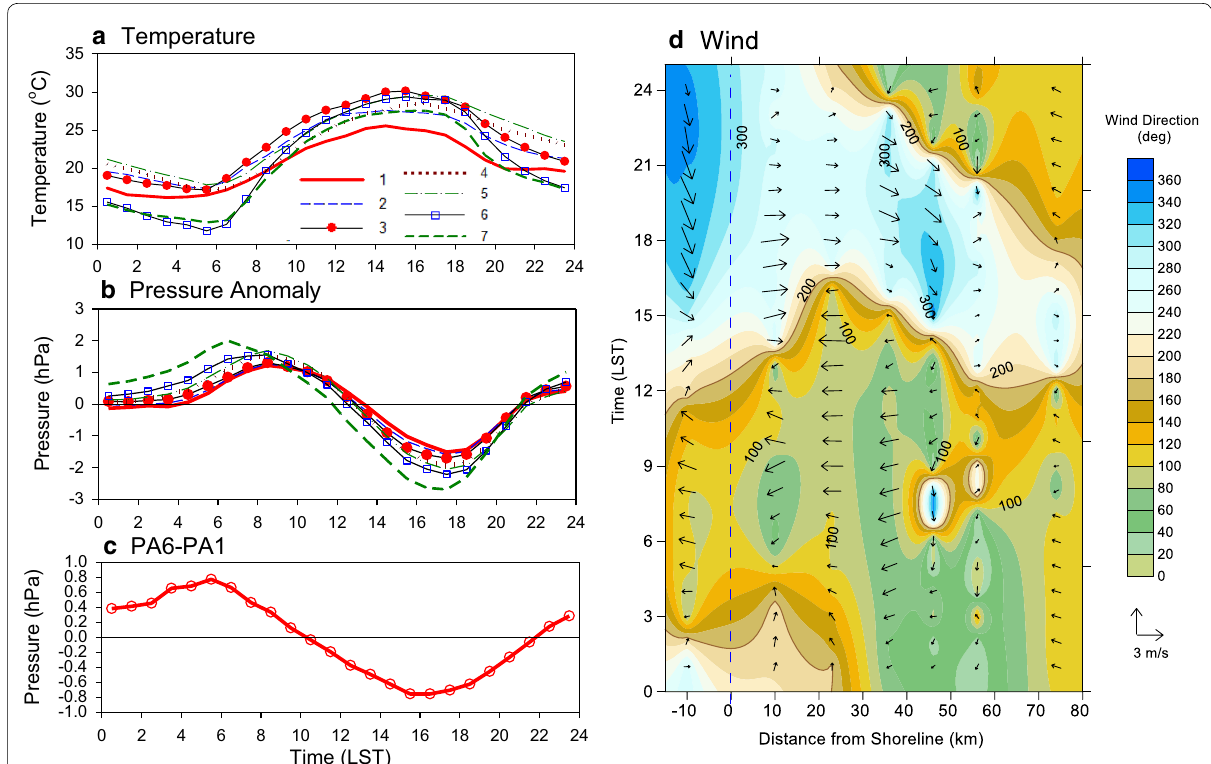
Fig. 2 Diurnal variation of a air temperature, b surface pressure anomaly at 7 stations, c pressure anomaly difference between Stations 6 and 1, and d time–distance cross section of wind at seven stations in the SMA. All data are averaged for the period of 17–22 May 2016, and the station number is indicated in Fig.